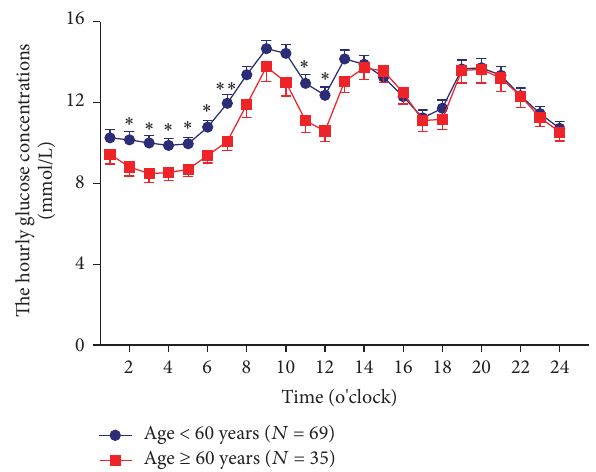
Figure 1: The hourly glucose concentrations in older patients ( ≥ 60 years)andyoungerpatients( < 60years).Dataarepresentedasmeans ± SD. A two-way ANOVA was used in the comparison between groups, ∗ 𝑃 < 0.05 and ∗∗ 𝑃 < 0.01